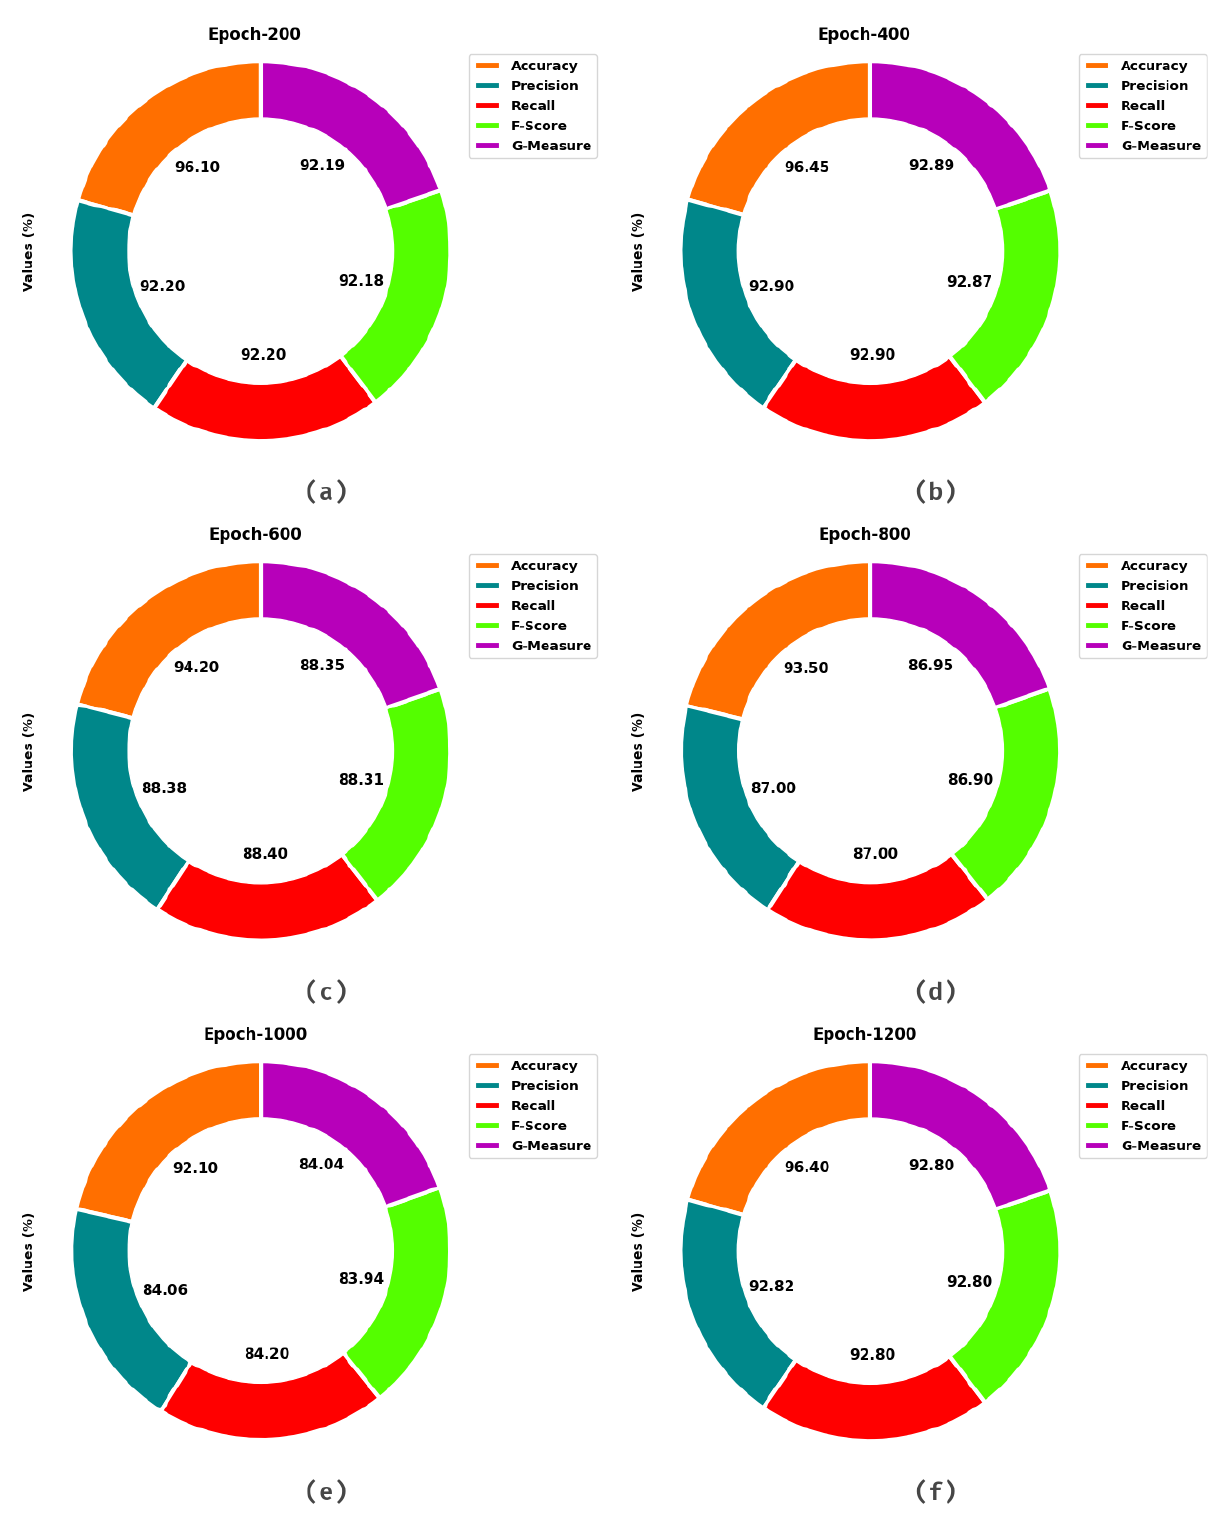
Figure 6. Average analysis of MDTL-ICDDC technique ( a ) epoch 200, ( b ) 400 epoch, ( c ) epoch 600, ( d ) epoch 800, ( e ) epoch 1000, and ( f ) epoch 1200.